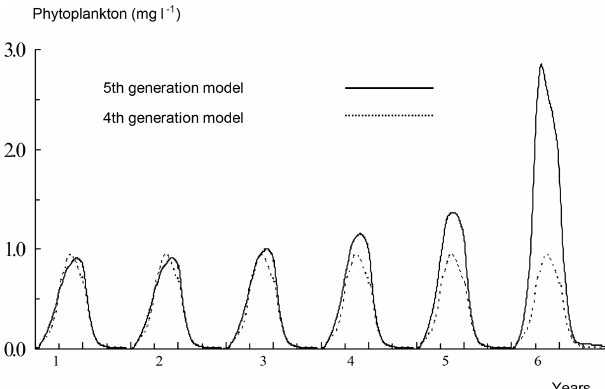
Figure 8. Modeling of inter-annual variability of phytoplankton content in the Novosibirsk reservoir